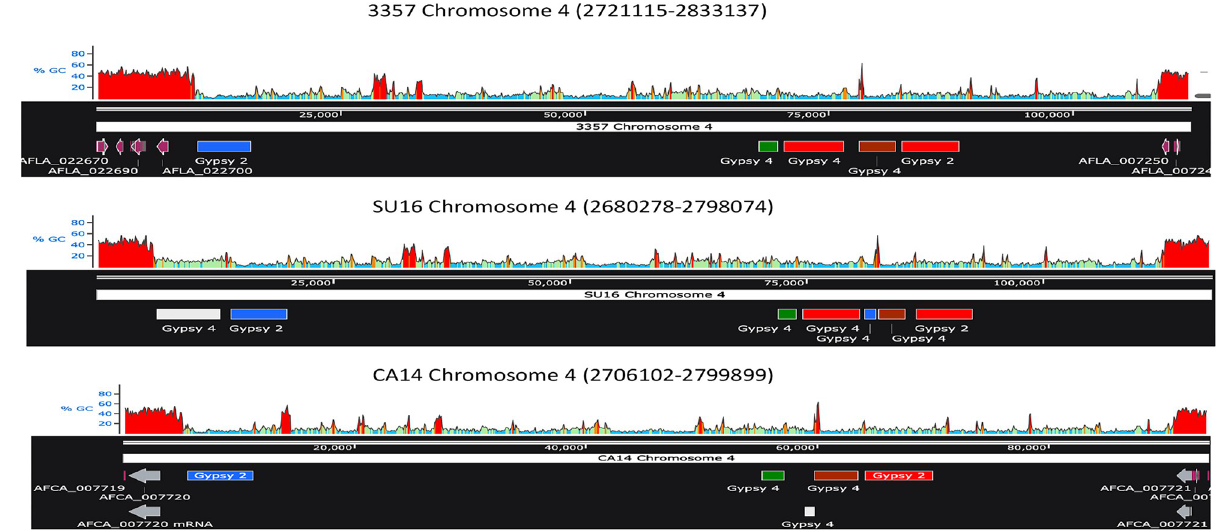
Fig 3. Organization of Gypsy element homologs at chromosome 4 centromeres in NRRL 3357, SU-16 and